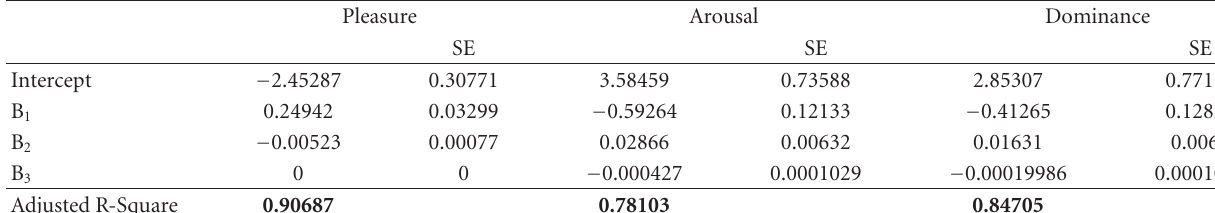
Table 7: Polynomial coe ffi cients for the modeling of PAD relationship on text size using (2) with their standard errors.